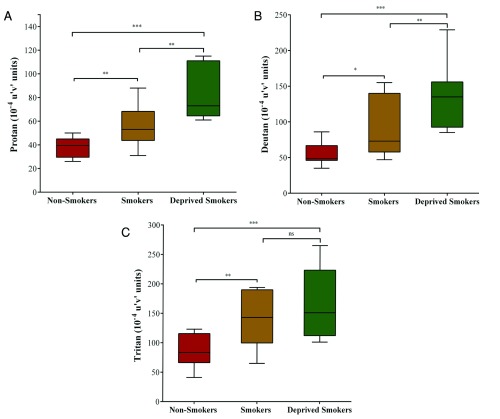
Trivector test: box-and-whiskers plots for protan (
A), deutan (
B) and tritan (
C) confusion lines. Data are presented in 10
-4 u’v’ units. Each box-and-whiskers plot is based on results for 45 participants. *
P < 0.05; **
P < 0.01; ***
P < 0.001.